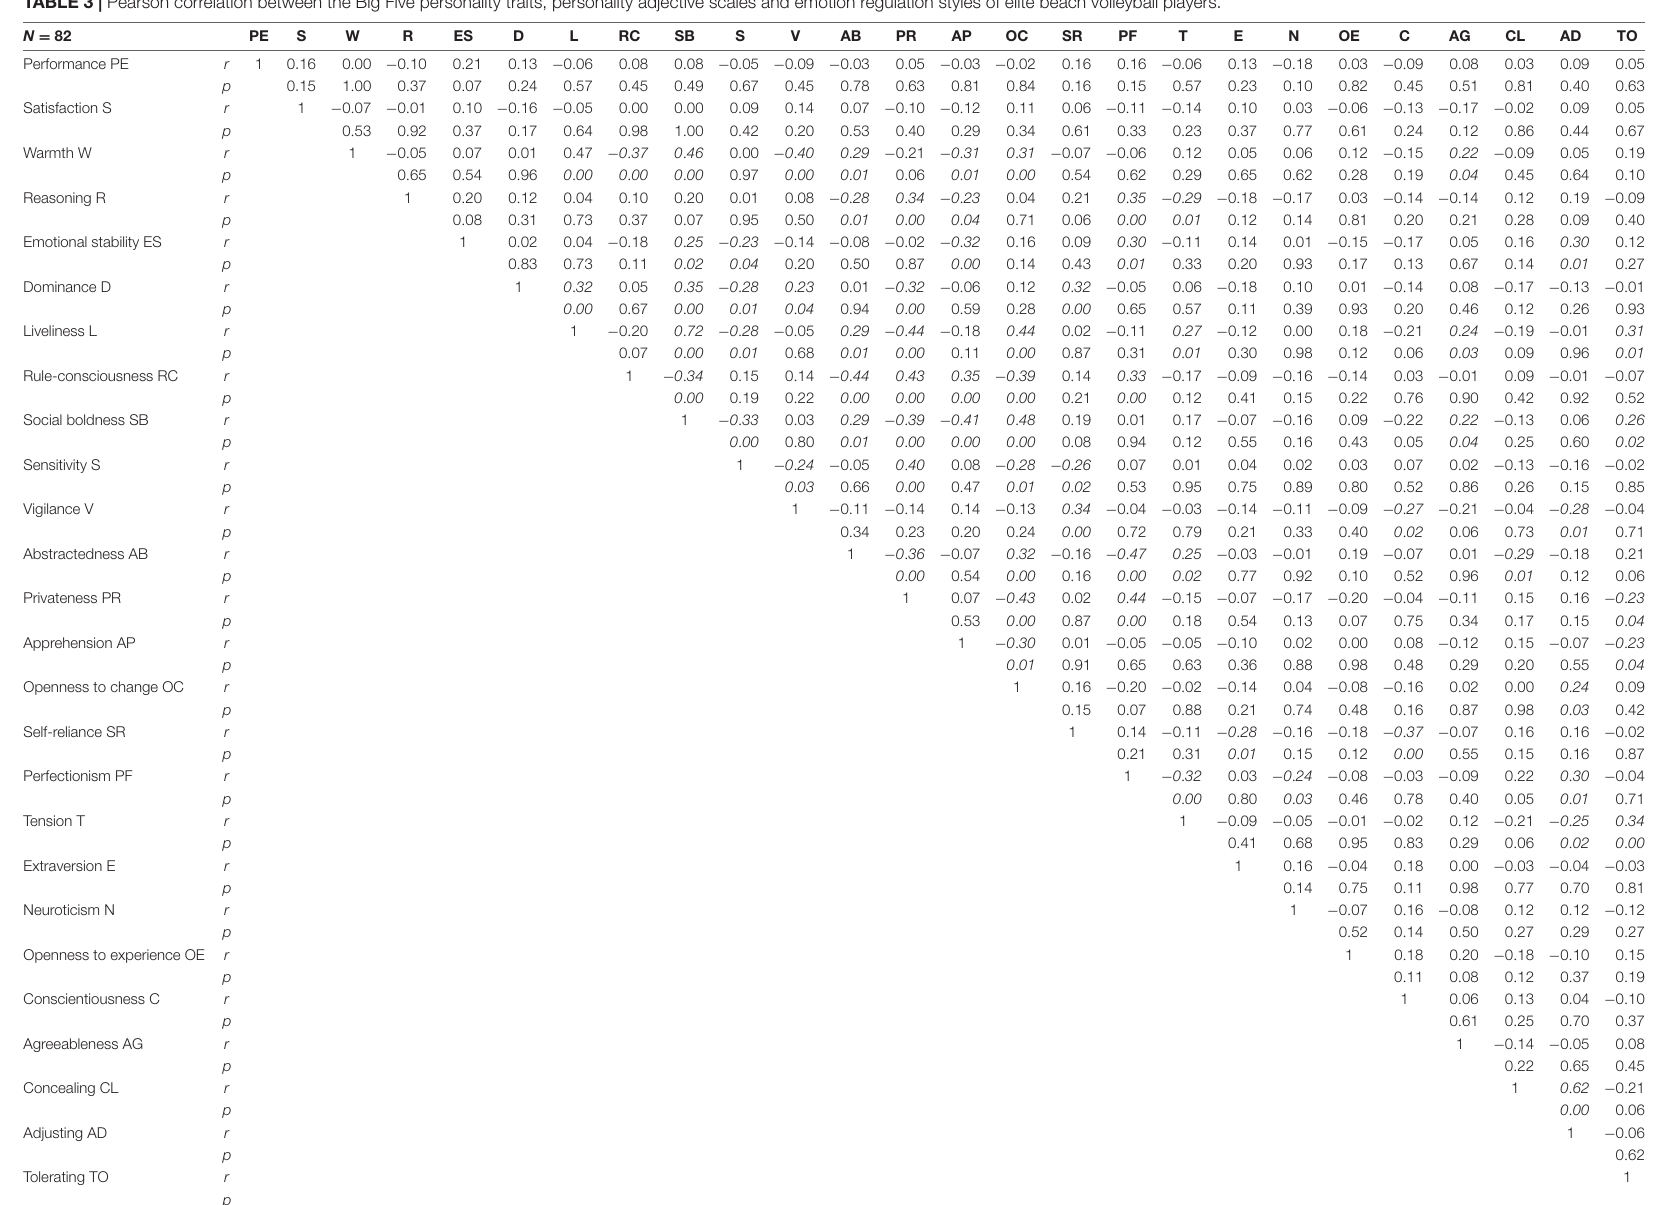
Italics represent significant